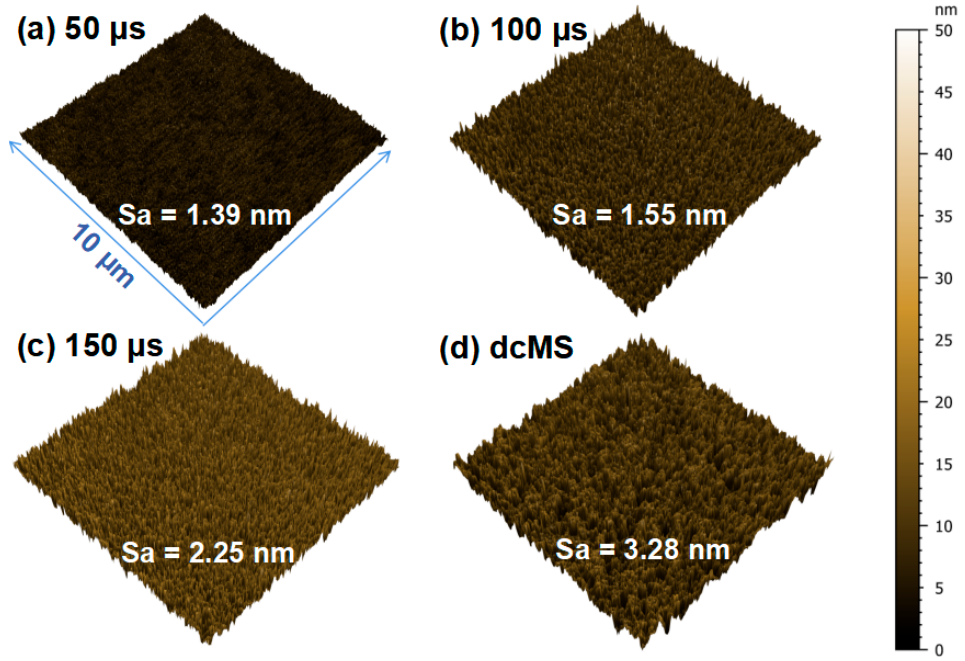
Figure 3. AFM morphologies and roughness of W thin films with respect to HiPIMS pulse length. There are three crystal structures of W, and their structures and properties are